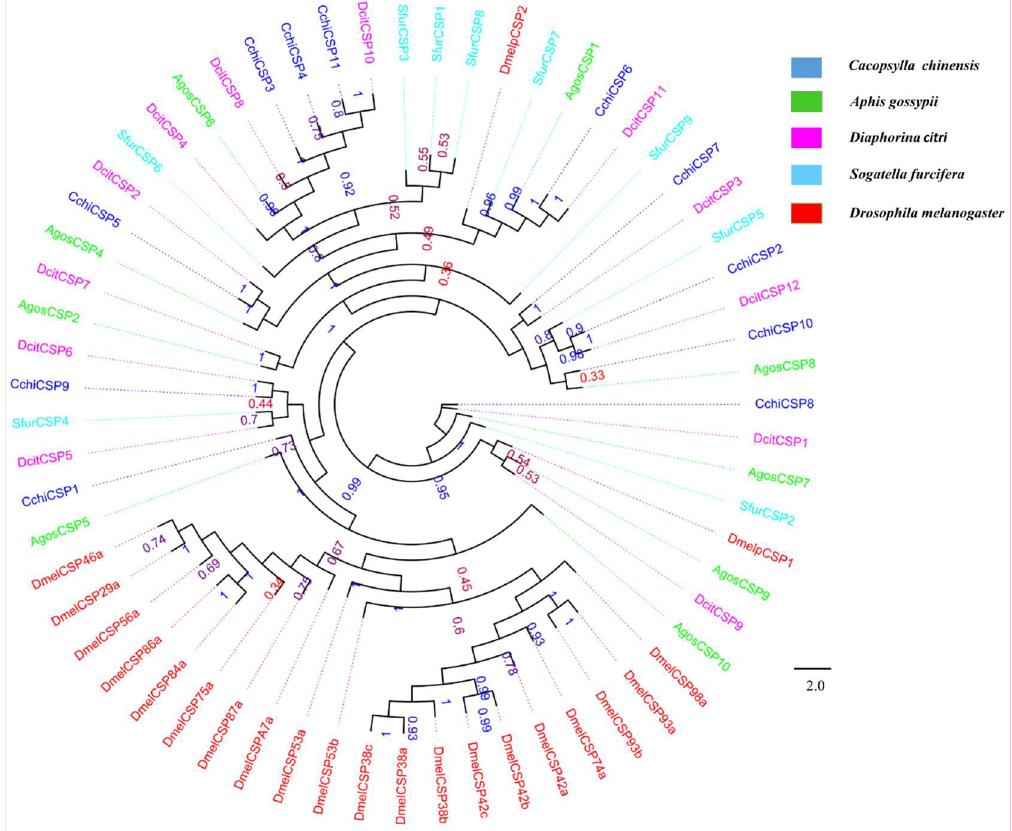
Figure 5. Phylogenetic tree of insect chemosensory proteins (CSPs). The C. chinensis translated genes are shown in blue. Other insects are as follows: Aphis gossypii , Diaphorina citri, Sogatella furcifera, Drosophila melanogaster . This tree was constructed using PhyML based on the alignment results of ClustalX2.0.